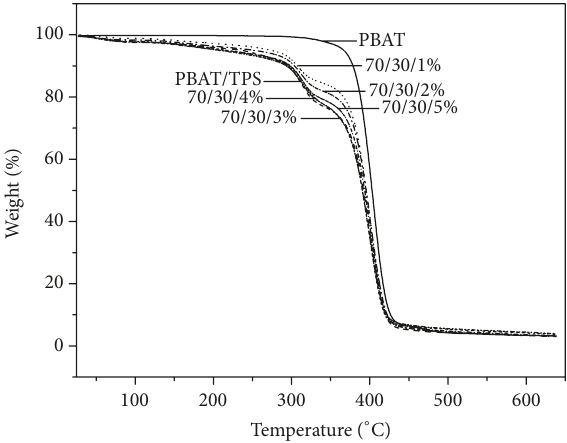
Figure 6: Thermogravimetric analysis of the